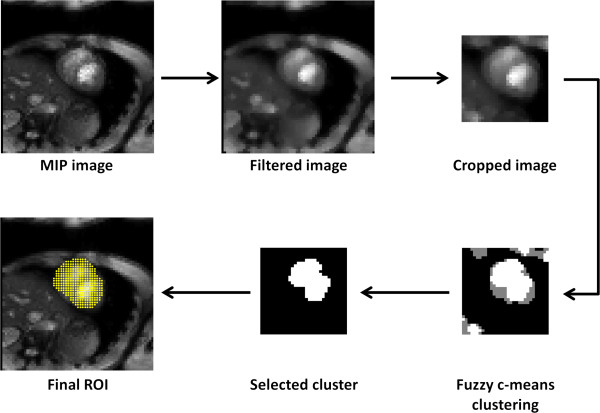
Procedures of automatic ROI selection. A MIP image is first generated from all the acquired sweep scan images. After applying a median filter, the procedure selects a square region consisted of 25 × 25 pixels and uses FCM clustering to distribute pixels into 3 groups according to the signal intensity. The group with the highest averaged intensity generates a binary mask. The binary mask then underwent erosion and subsequent dilation to remove small objects and connect neighboring objects in the mask. Finally, the procedure selected an object with the center of mass closest to the center of FOV as heart ROI (indicated as yellow dots).